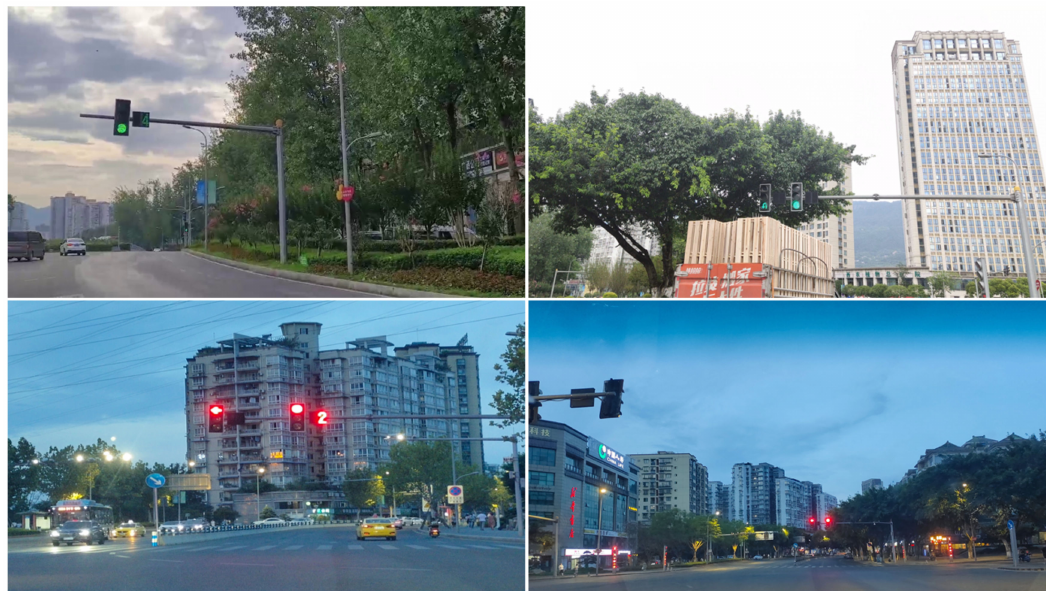
Figure 8. Example images of self-made dataset.